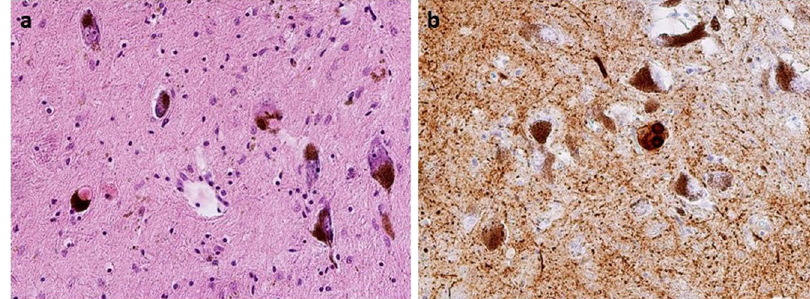
Fig. 1 Pure alpha-synucleinopathy in typical Parkinson ’ s disease phenotype. a Classical Lewy bodies in the pigmented neurons of substantia nigra, HE staining, original magni fi cation ×200. b Pathological deposits of α -synuclein in substantia nigra — Lewy bodies, granular cytoplasmic positivity, and dystrophic neurites, stained with a monoclonal antibody against α -synuclein, original magni fi cation ×200.